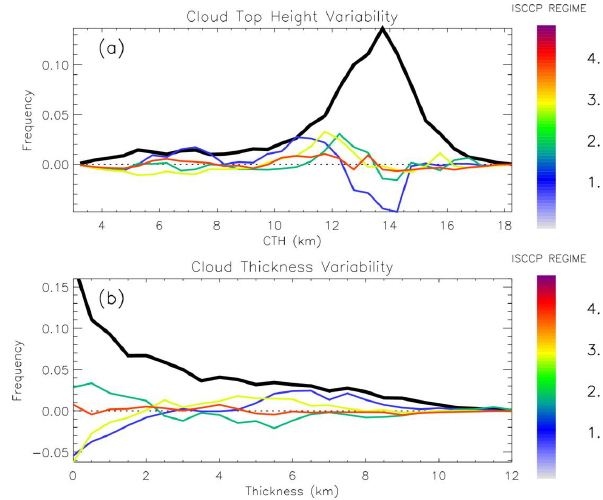
Figure 12: Same as Fig. 4 but for the ISCCP regimes: CD (blue), STC (green), CC (yellow), and MIX (red).